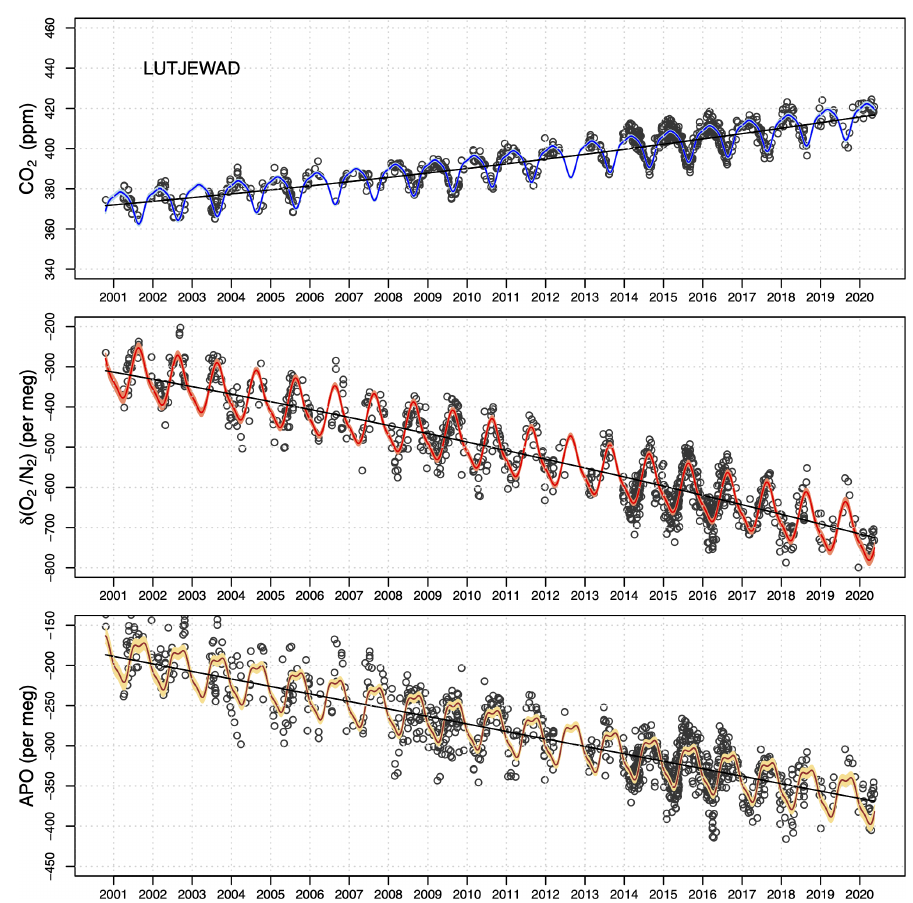
Figure 7. Flask record from Lutjewad station, showing CO 2 , δ (O 2 / N 2 ), and APO measurements from 2000 to 2020. The black points are the individual flask measurements, the black lines are the long-term trends, and the coloured lines indicate the trends with seasonal components derived from the combined quadratic and harmonic regression. The uncertainty ranges (2 σ ) in the fits are indicated by lighter shades of the same colours. For comparability, the y -axes ranges are scaled to represent the 5 per meg : 1ppm ratio.